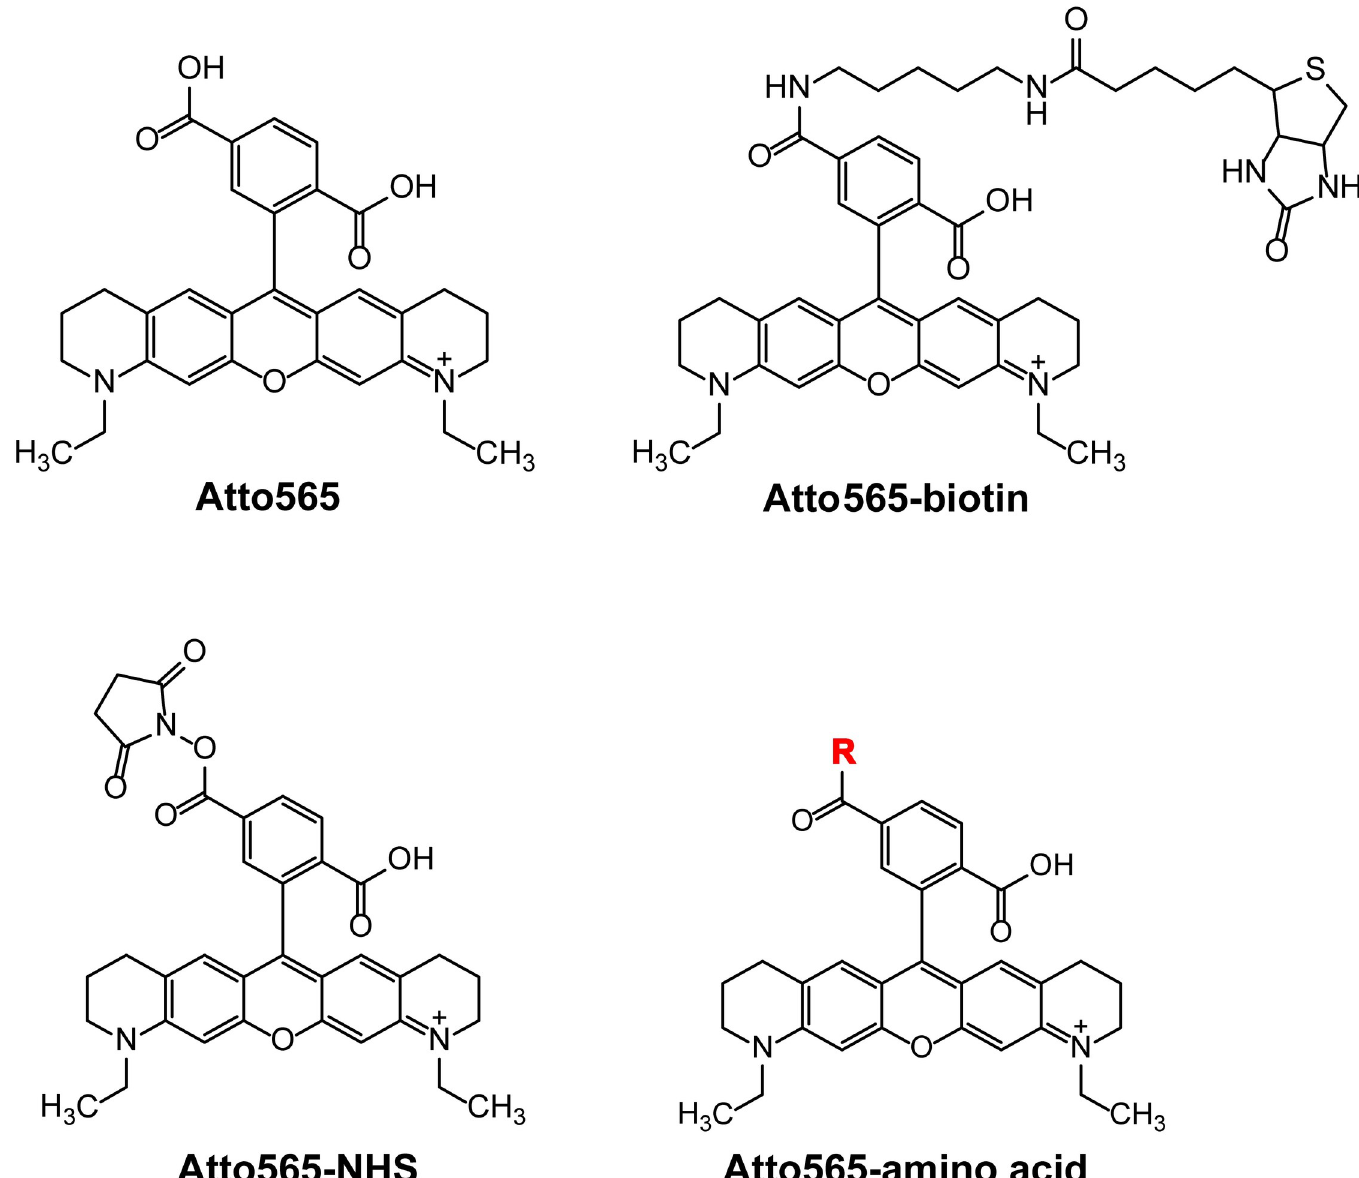
Fig 7. Chemical structures of Atto565, Atto565-biotin, Atto565-NHS ester and the Atto565 labelled with various amino acids (Glycine, Lysine, Arginine, Aspartic acid, Glutamic acid, Asparagine, Glutamine) represented by -R group.